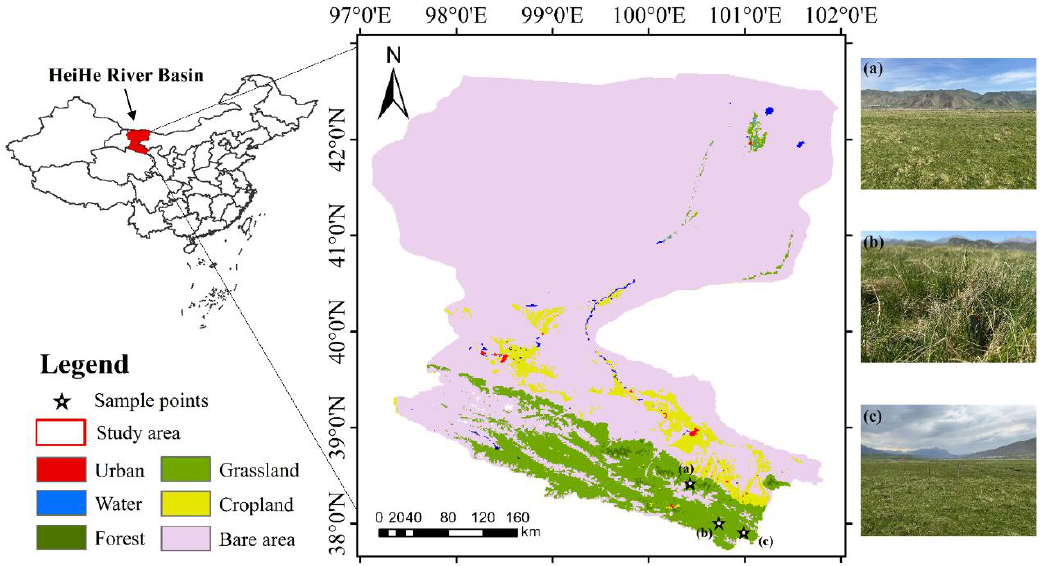
Figure 1. The study area location. The background shows the land cover types, which were derived from the CCI-LC for 2015